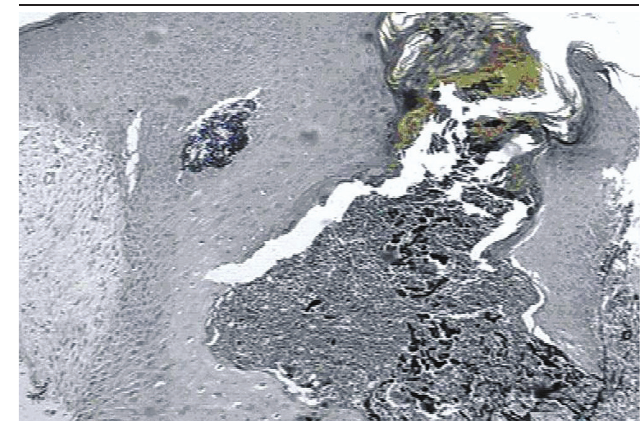
FigurE 4 − Transepidermal elimination of degenerated elastic fibers (Verhoeff,